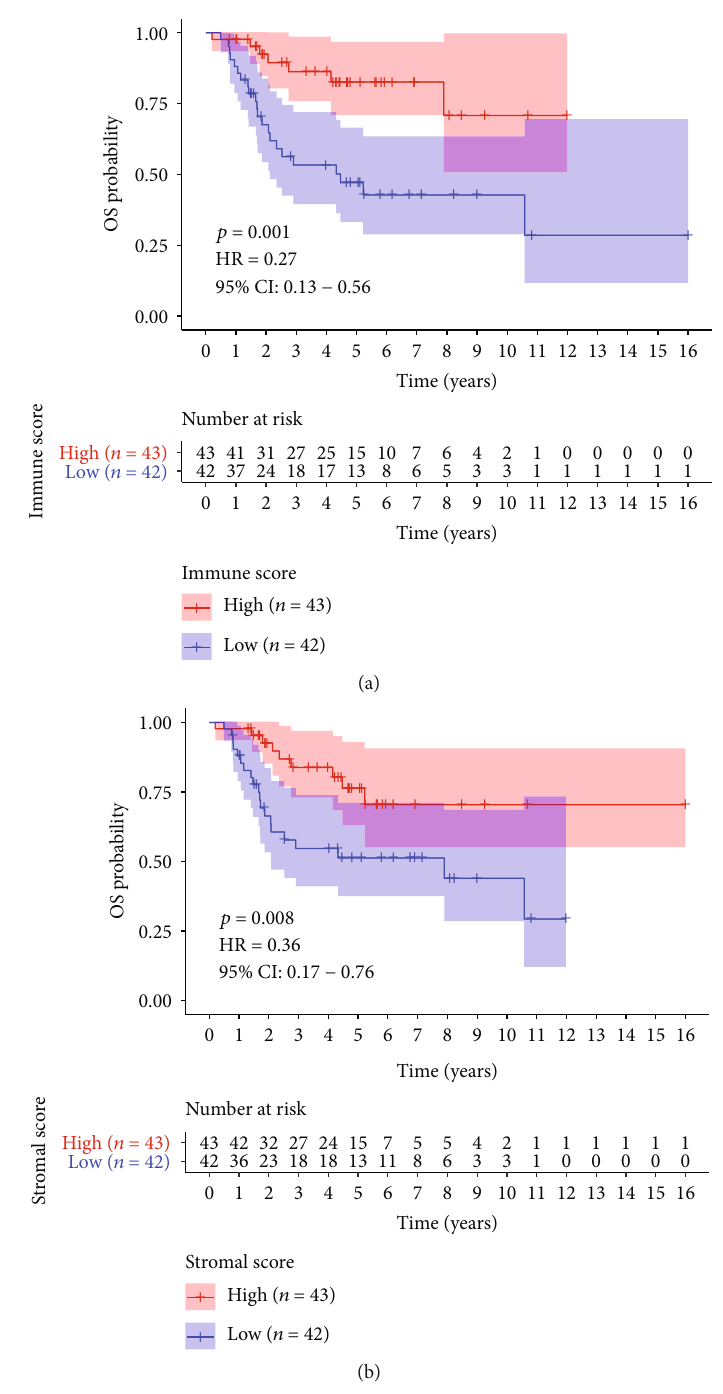
Figure 2: The relationship between immune score and stromal score for OS prognosis. (a) Survival analysis of the correlation between immune score and overall survival time in OS. (b) Survival analysis of the correlation between stromal score and overall survival time in OS. Immune/stromal scores: the signi fi cance is to predict tumor purity by immune and stromal scores. Log-rank p values were less than 0.05 with statistically signi fi cant. OS: